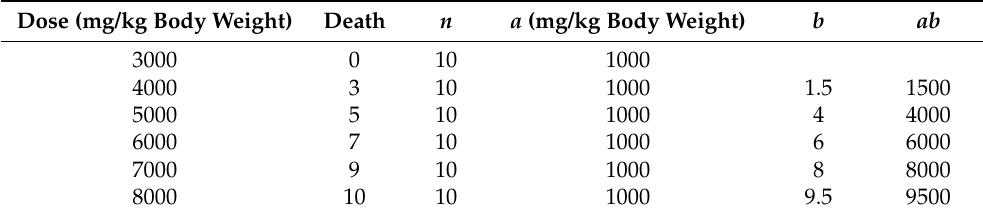
Table 2. Test data for determination of LD 50 values for penicillin IVb ( n —number of mice in each group, a —difference between two consecutive doses, and b —average value of the deaths from two consecutive doses).